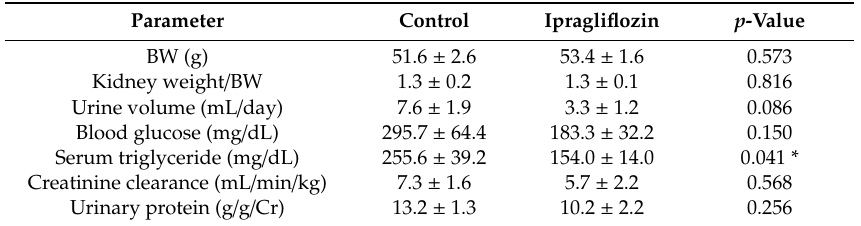
Table 1. Metabolic characteristics in the two mice